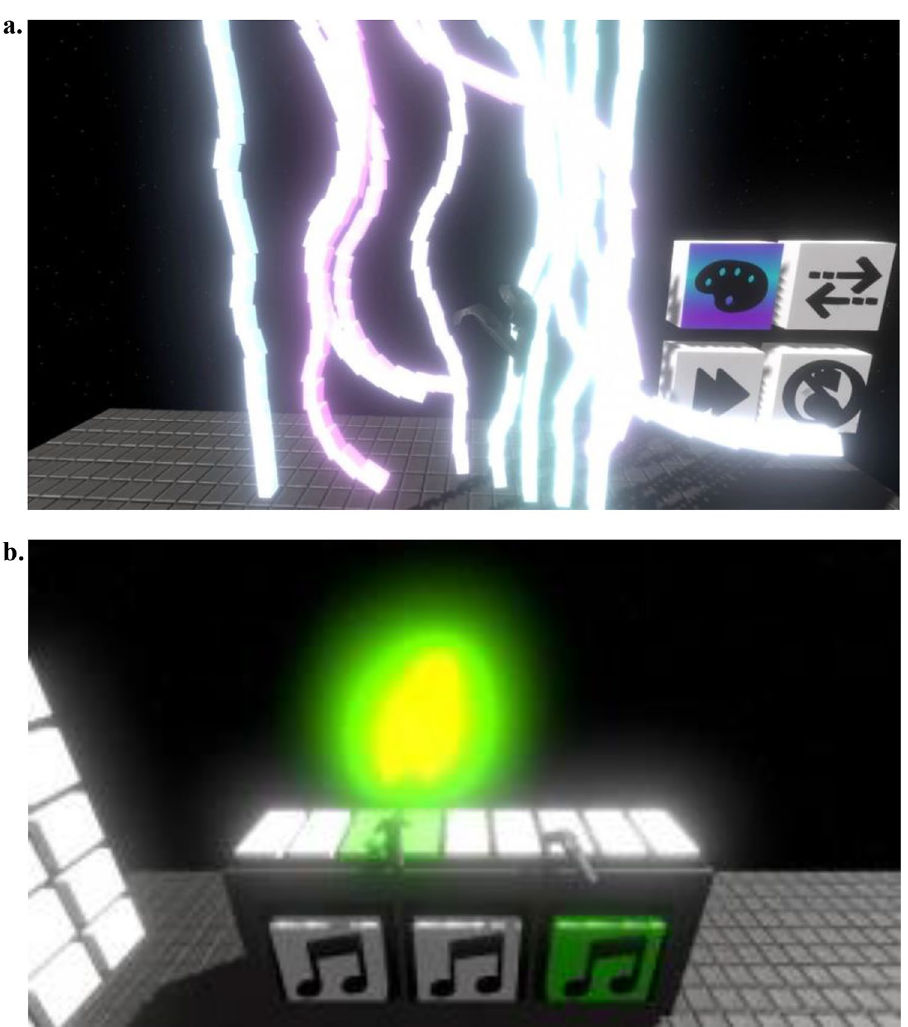
Figure 2. Evenness VR Sensory Room: Screen shots of interactive spaces from the user perspective. ( a ) light curtain with colour change option and ( b ) interactive